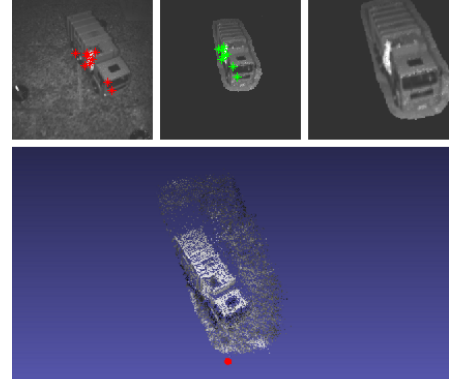
Figure 6: SIFT-based object detection and segmentation: normal- ized active intensity image, template and transformed template (upper row, from left to right). The corresponding point cloud for the area of the transformed template and the sensor position (red dot) are shown